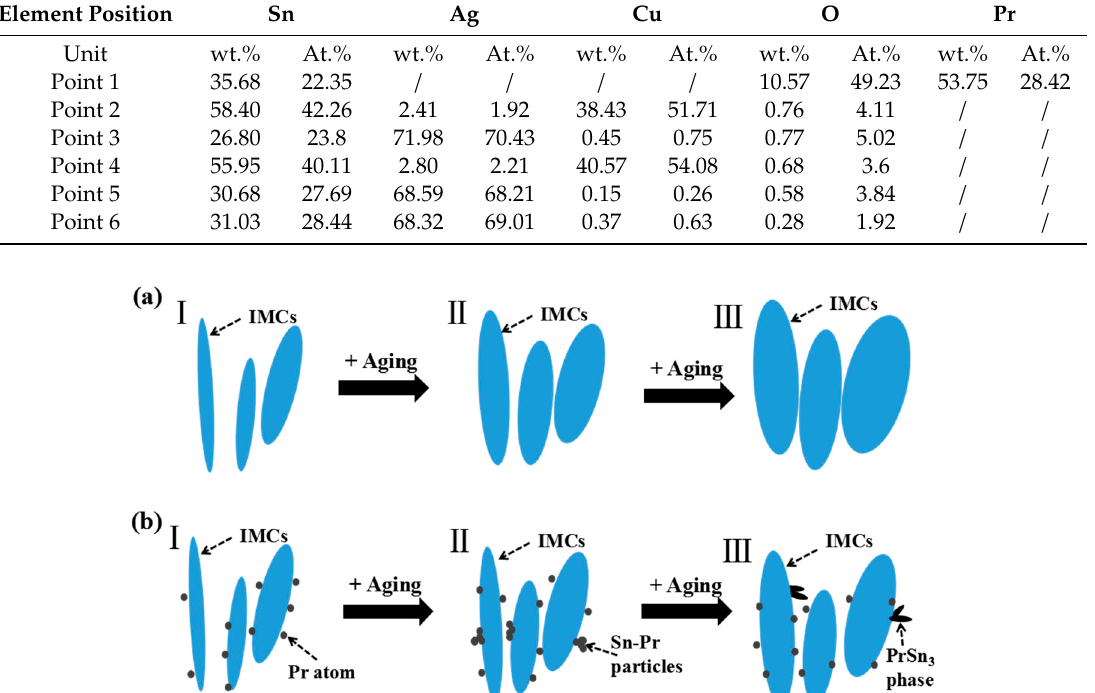
Figure 2. Illustration of changes in IMCs in ( a ) SAC0307 solder and ( b ) SAC0307-0.05Pr solder during aging process.